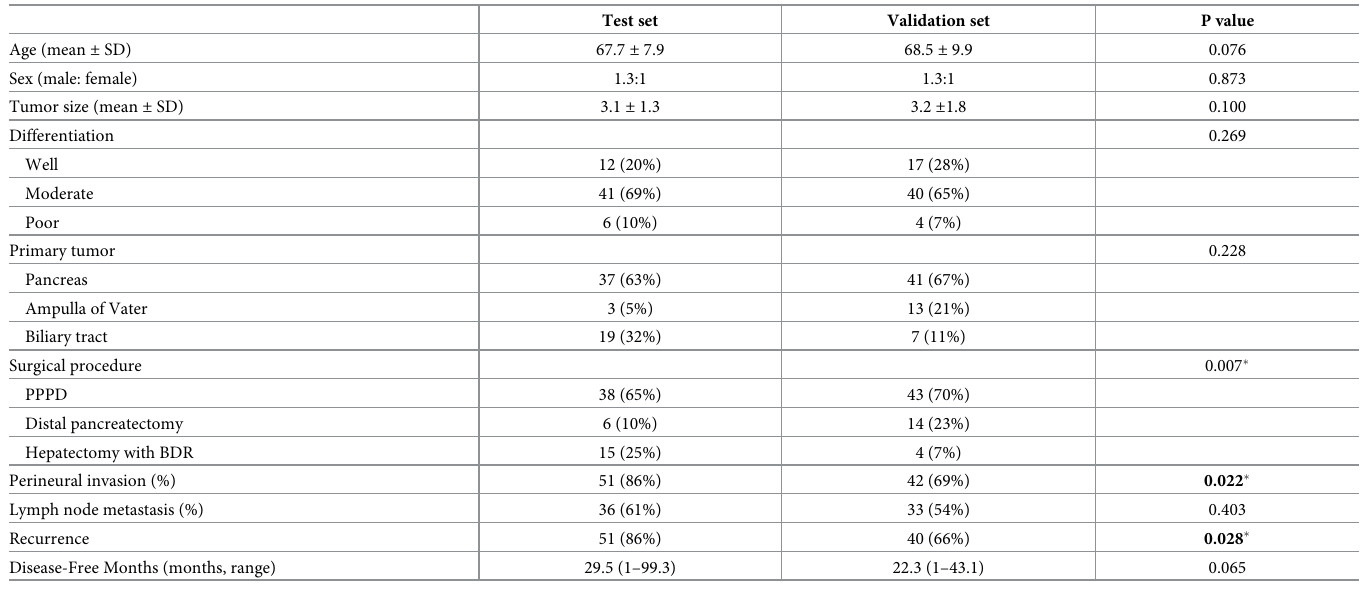
Table 1. Clinicopathologic characteristics of the test and validation sets.